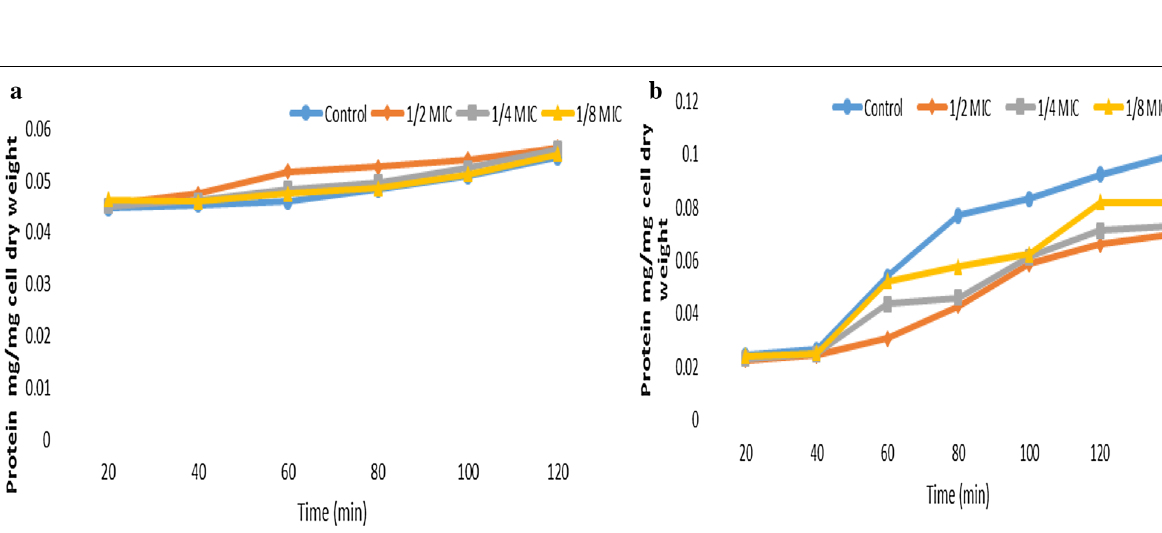
Fig. 3 Effect of different Citrus lemon leaves oil on the proteins biosynthesis in cells of P. aeruginosa ( a ), S. aureus ( b